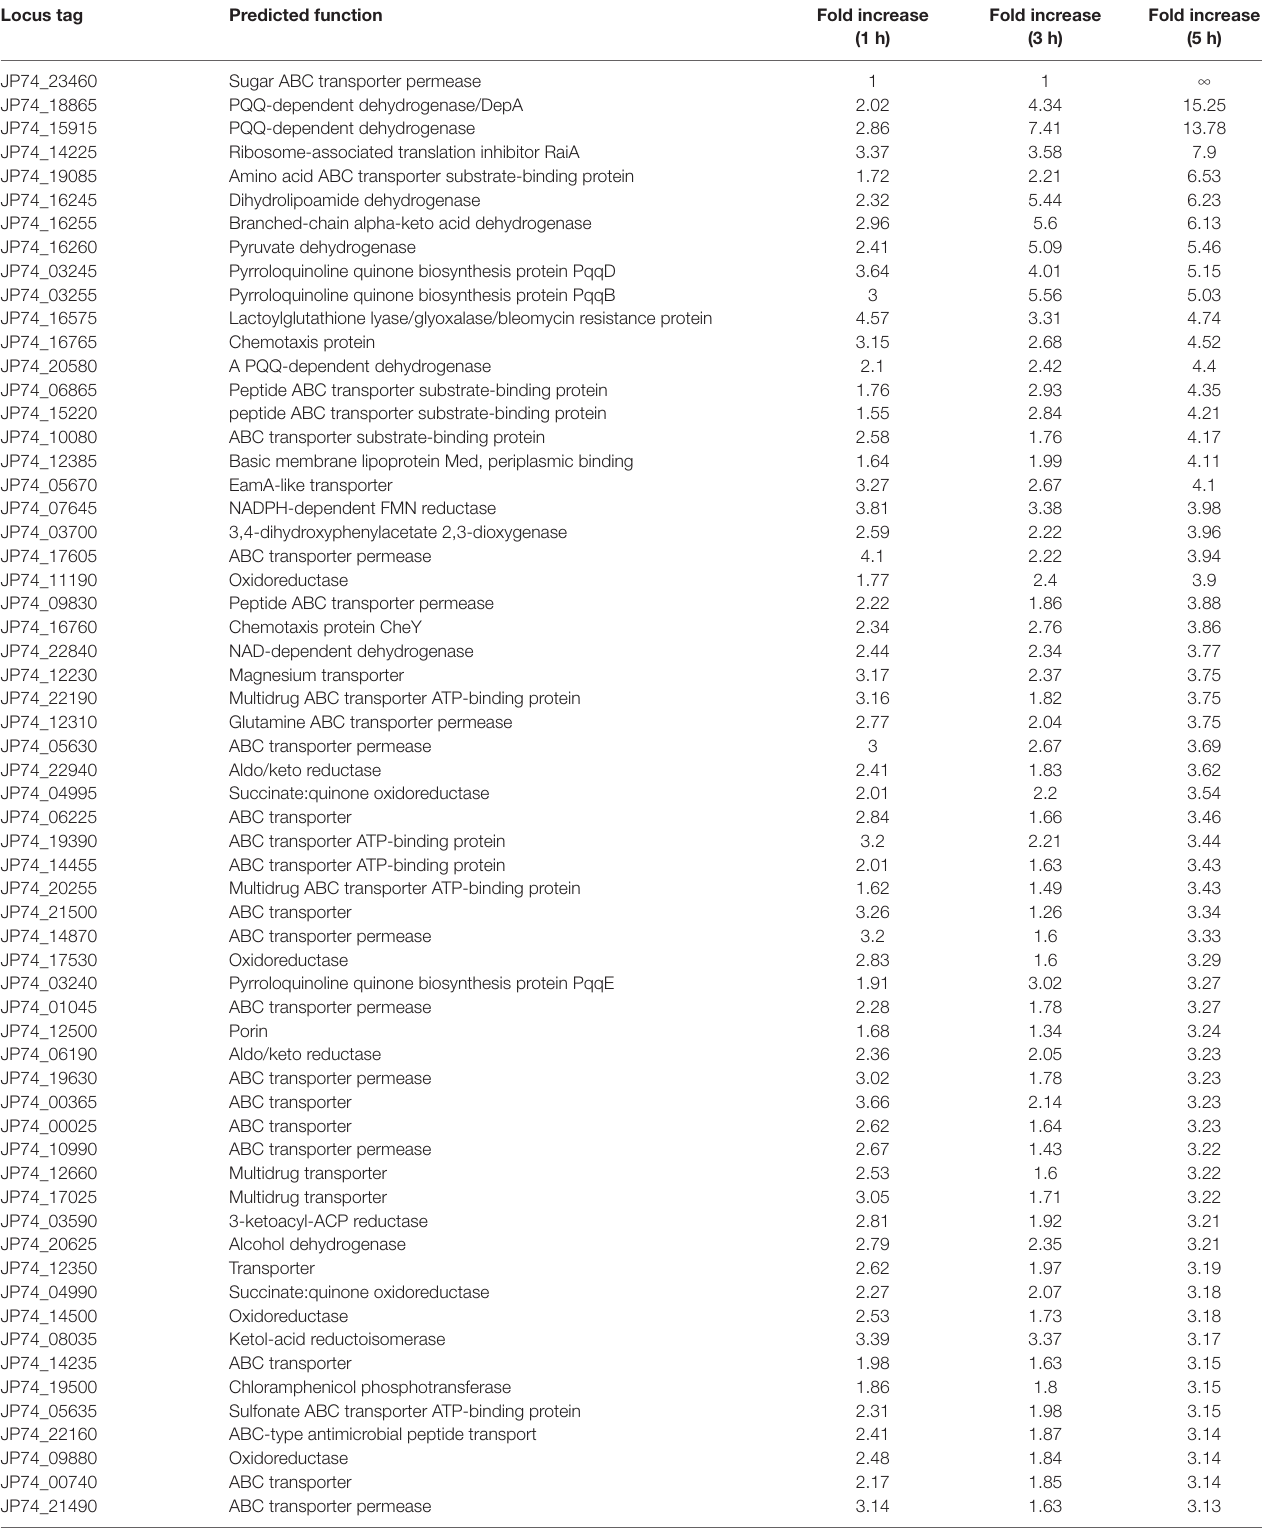
TABLE 1 | Devosia mutans 17-2-E-8 genes related to detoxification/defense mechanism(s) that were upregulated due to deoxynivalenol (50 µg/ml) inclusion in bacterial growth media. Locus tag Predicted function Fold increase